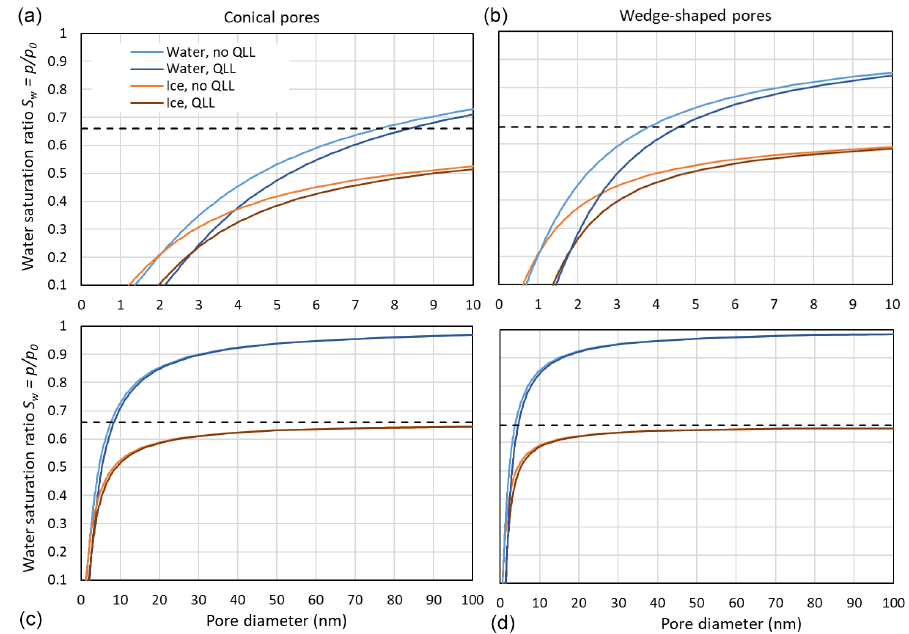
Figure 9. Comparison of pore filling with water and ice for conical (a, c) and wedge-shaped (b, d) pores at 230K. For water and ice, the Kelvin effect is calculated without QLL, given as light blue and light brown lines, respectively, and assuming a QLL with width t = 0 . 38nm, given as dark blue and dark brown lines, respectively. The black, dashed horizontal line indicates ice saturation.